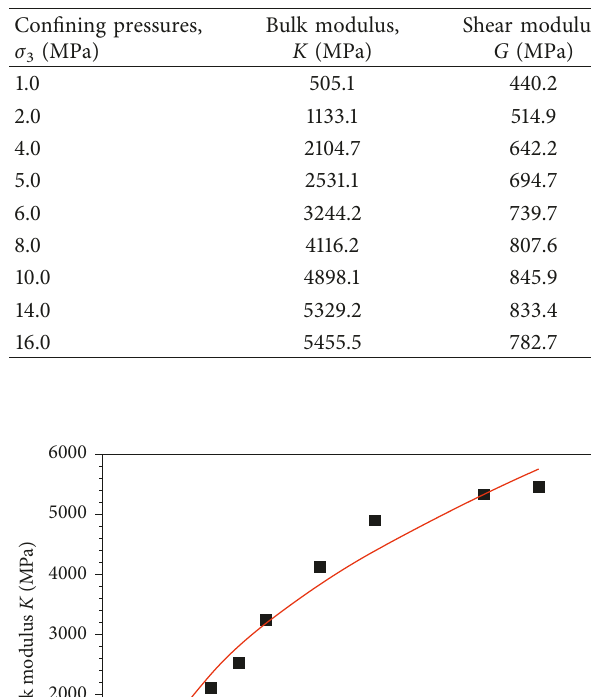
Table 1: Basic physical parameters determined.